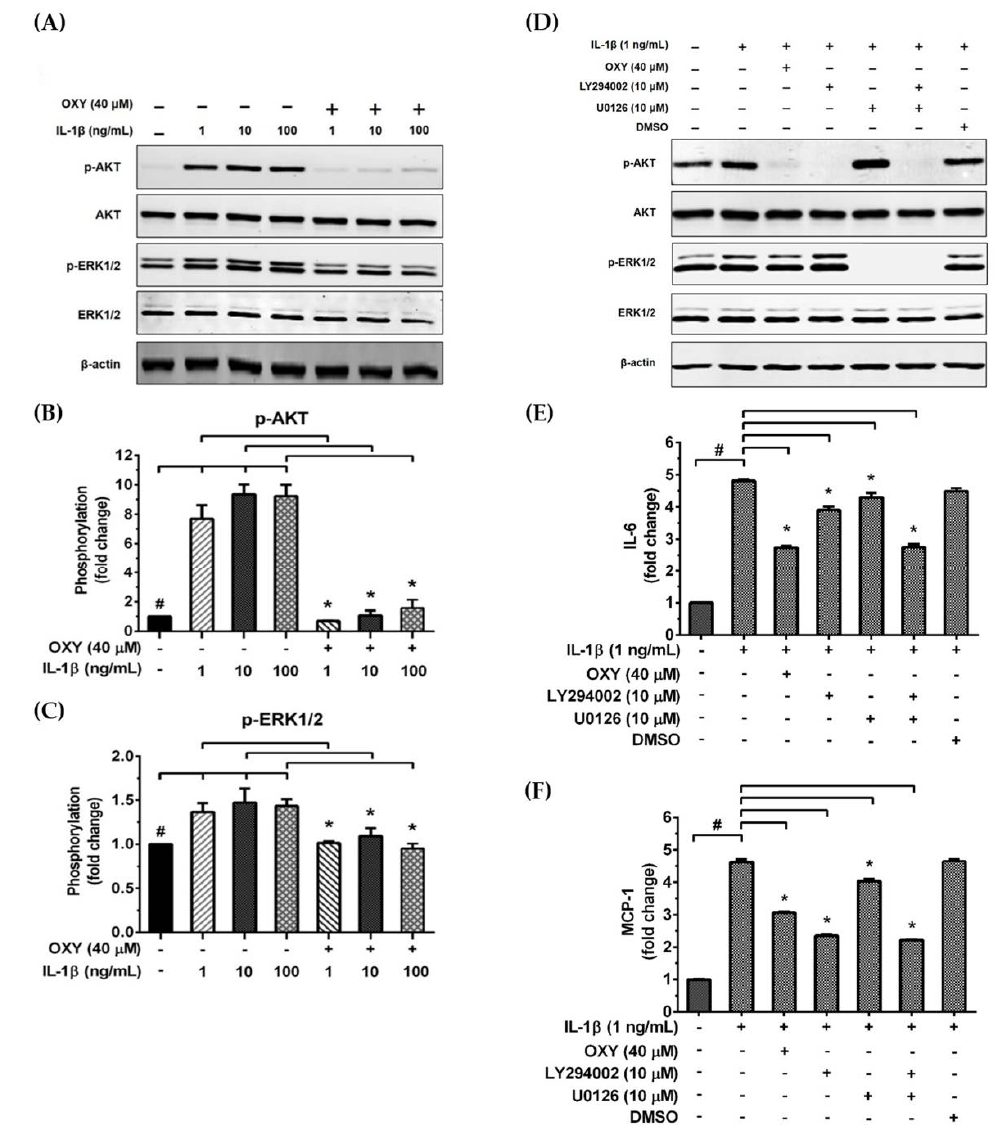
Figure 6. ( A ) Western blot analysis for the inhibitory effects of OXY on AKT and ERK1/2 phosphorylation in HMC3 after being treated with OXY (40 μM) for 4 h before stimulation with various concentrations of IL-1β (1, 10, and 100 ng/mL) for 20 min; ( B ) quantitative analysis for AKT phosphorylation at Ser473; ( C ) quantitative analysis for ERK1/2 phosphorylation. Total AKT and total ERK1/2 were detected and used as an internal control. ( D ) Western blot analysis detecting the phosphorylation status of AKT and ERK1/2 in response to IL-1β (1 ng/mL) for 20 min with or without the presence of 10 μM of LY294002 or 10 μM of U0126. The level of IL-6 ( E ) or MCP-1 ( F ) in the culture supernatants of HMC3 cells stimulated with IL-1β, with or without the presence of LY294002 or U0126. Data are represented as mean ± SD of three independent experiments; # p < 0.05 (compared to the untreated group) or * p < 0.05 (compared to the IL-1β-treated groups).